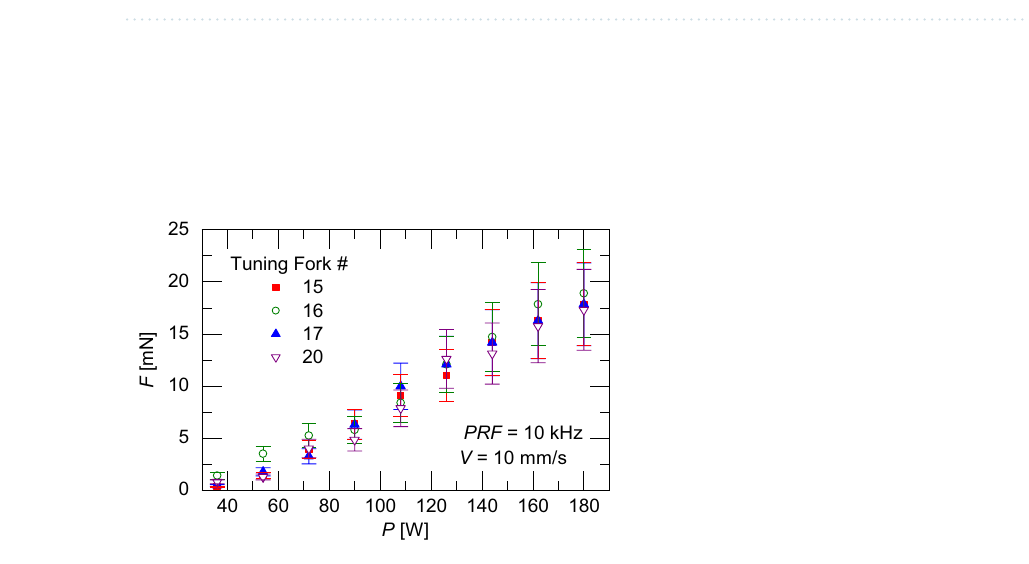
Figure 4. Results for Tuning Fork #16 (a) measured FRFs for various laser powers, (b) measured acceleration spectrum with inset showing single line scanning strategy schematic, and (c) calculated forcing spectrum with SNR spectrum (gray line). V = 10 mm/s.